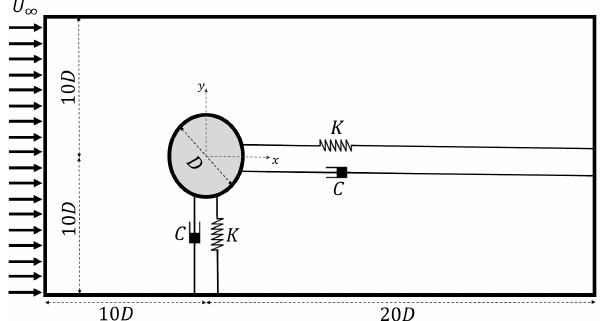
Figure 2. Computation domain and problem